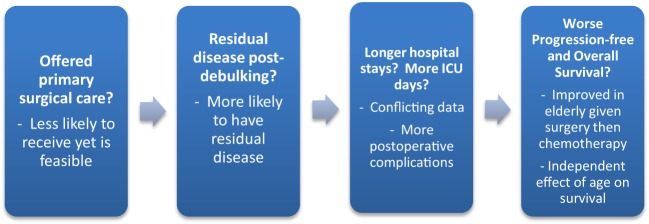
Primary surgical treatment for elderly women with ovarian cancer.